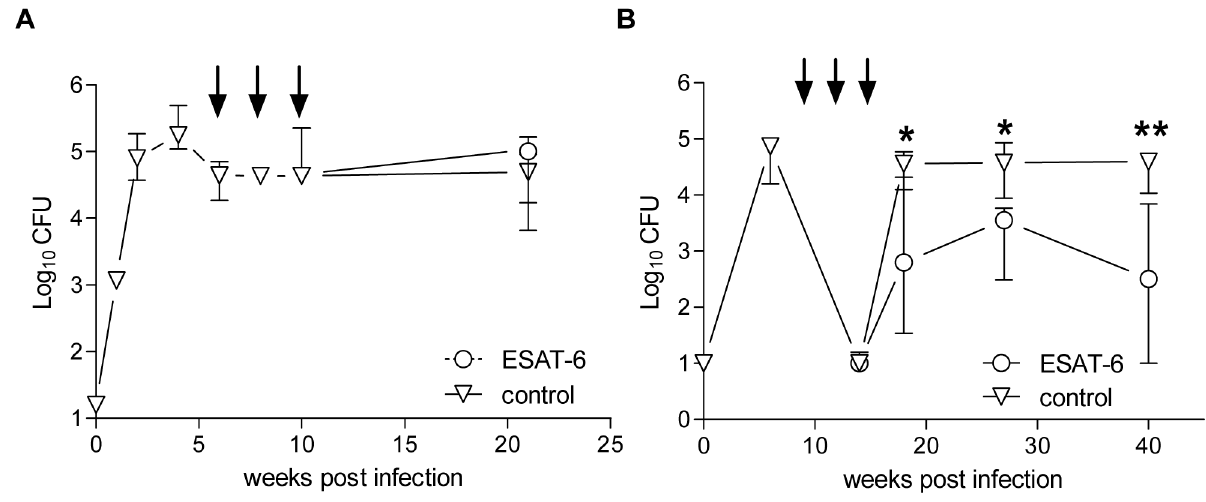
Figure 7. Comparison of therapeutic and post-exposure vaccine efficacy. (A) In the therapeutic model, CB6F1 mice were aerosolly infected and vaccinated three times with two weeks interval starting at week 6 post infection (p.i.) (black arrows) with ESAT-6/CAF01 (open circle) or CAF01 alone (open triangle). The therapeutic efficacy was assessed at week 21 p.i. Data shown are median values ± interquartile range week 0-20 from 3-8 individual animals and at week 21 p.i. n=7 for control animals and n=8 for ESAT-6 vaccinated. The two groups were compared with a Mann Whitney U-test and p<0.05 was considered significant. (B) In the post-exposure model, mice were infected for six weeks and then given antibiotics for six weeks, as described in materials and methods. Groups of mice were vaccinated with ESAT-6/CAF01 or CAF01 alone at week 10, 12 and 14 p.i. (black arrows) and protection assessed at week 18, 27 and 40 p.i. by culturing lung homogenates and enumerating the number of bacteria (expressed as log ). Data shown are median values ± interquartile range for the control group (open triangles, n=6) and ESAT-6 vaccinated 10 group (open circle, n=6). Values marked with an asterisk are significantly different from naïve control animals as assessed by non- parametric Mann-Whitney U-test (**, p <0.01, *, p